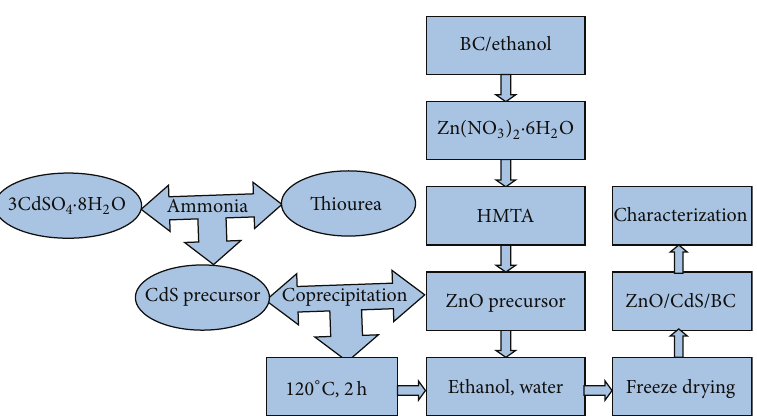
Figure 1: Schematic preparation process of hybrid ZnO/CdS/BC